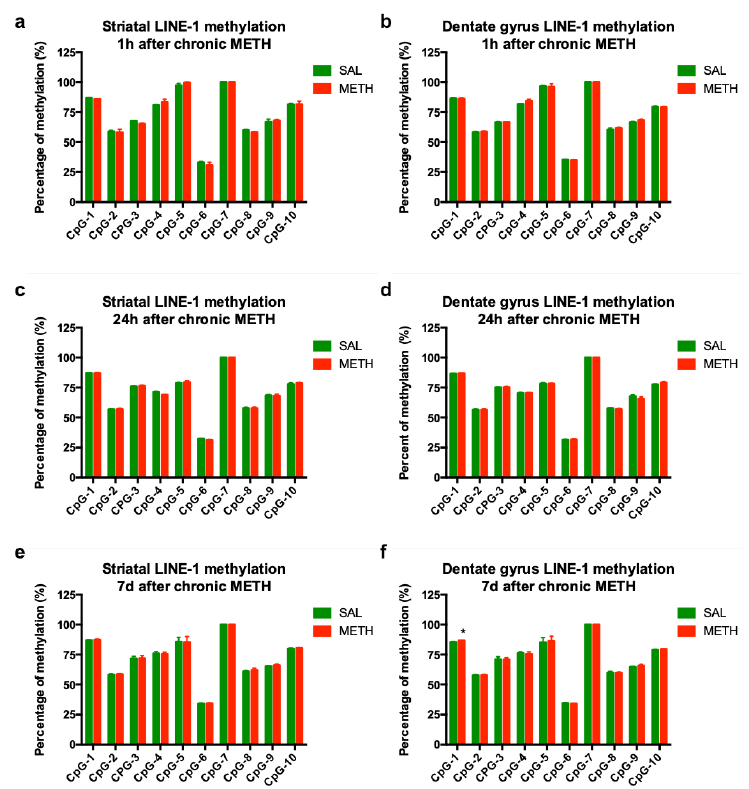
Figure 6. The effect of chronic METH administration (20 mg/kg/d, for 10 d, i.p.) on LINE-1 promoter methylation in the striatum ( a , c , e ) and dentate gyrus ( b , d , f ) at 1 h ( a , b ), 24 h ( c , d ), and 7 d ( e , f ) after the last dose of METH or saline. Abbreviations: d, day; METH, methamphetamine; SAL, saline. * Statistical significance p < 0.05, METH vs. SAL.